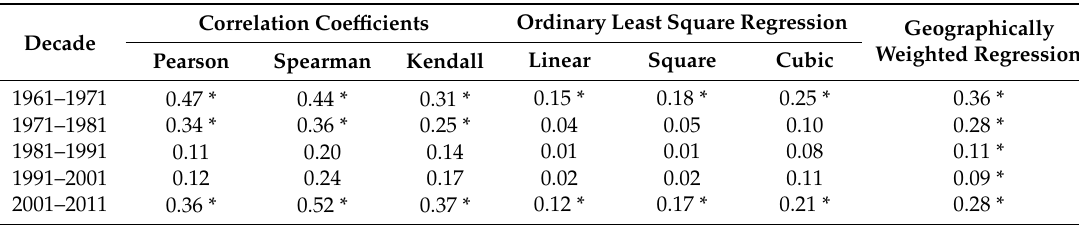
Table 3. Analysis of the linkage between population increase (%) and density using di ff erent correlation coe ffi cients, linear and non-linear (square, cubic) aspatial regressions (adjusted R 2 ) and a Geographically weighted regression (global adjusted R 2 ) for municipalities in Greece (* significance tested at p < 0.001, n =